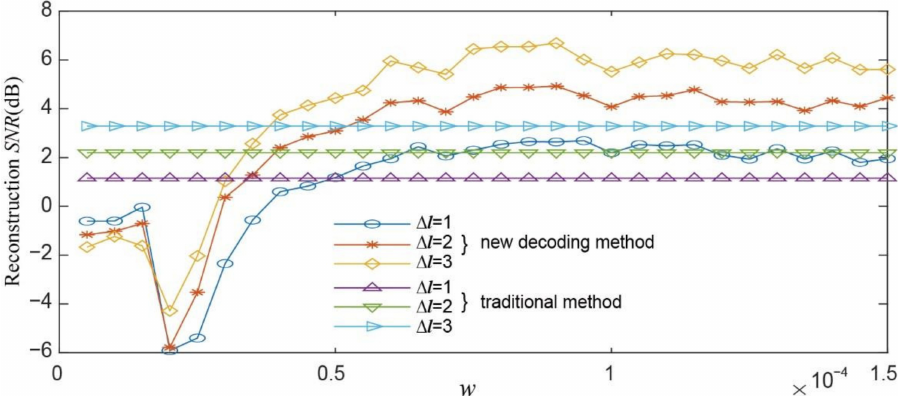
Figure 7. Comparisons of SNR of different decoding